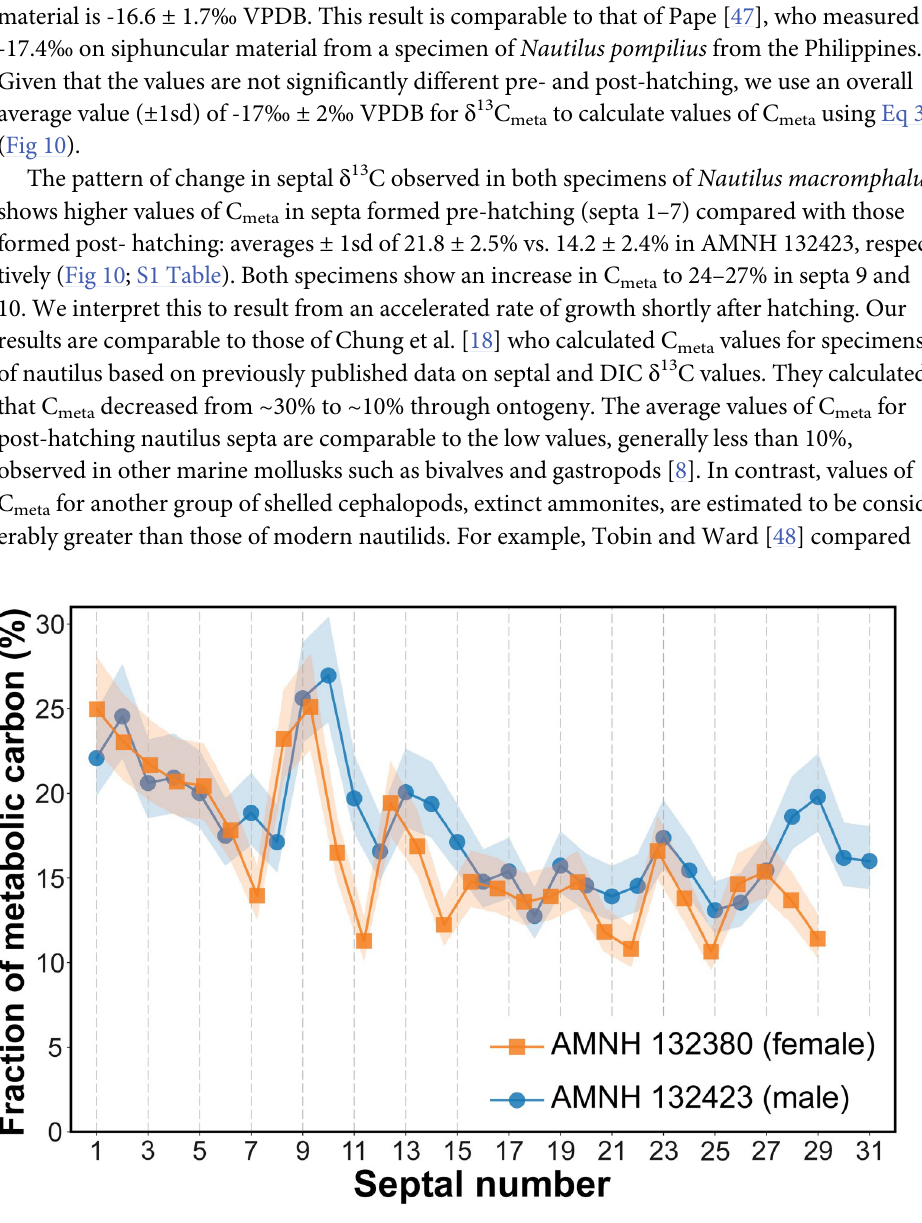
Fig 10. Reconstructed fraction of metabolic carbon in Nautilus macromphalus . Shaded areas indicate the estimated uncertainty in C meta given the average ± 1sd of δ 13 C meta (-17 ±